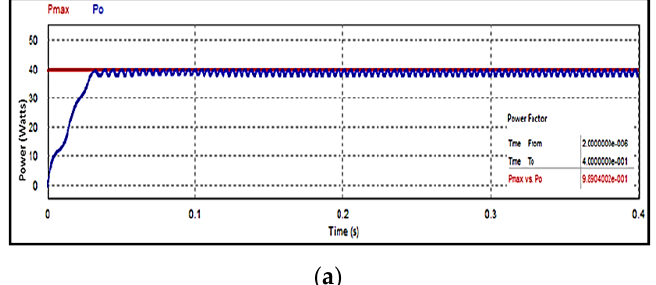
Figure 13. Duty vs. time.